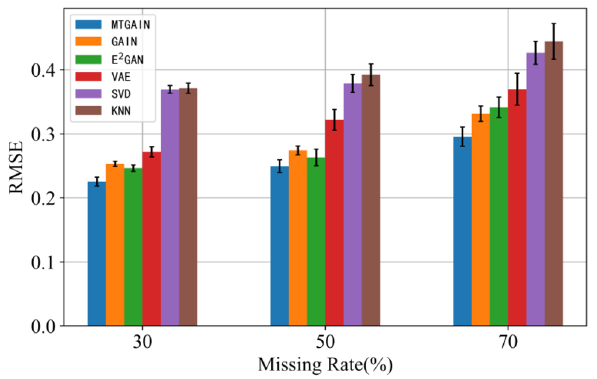
Fig. 7 RMSE performance comparison in MCAR